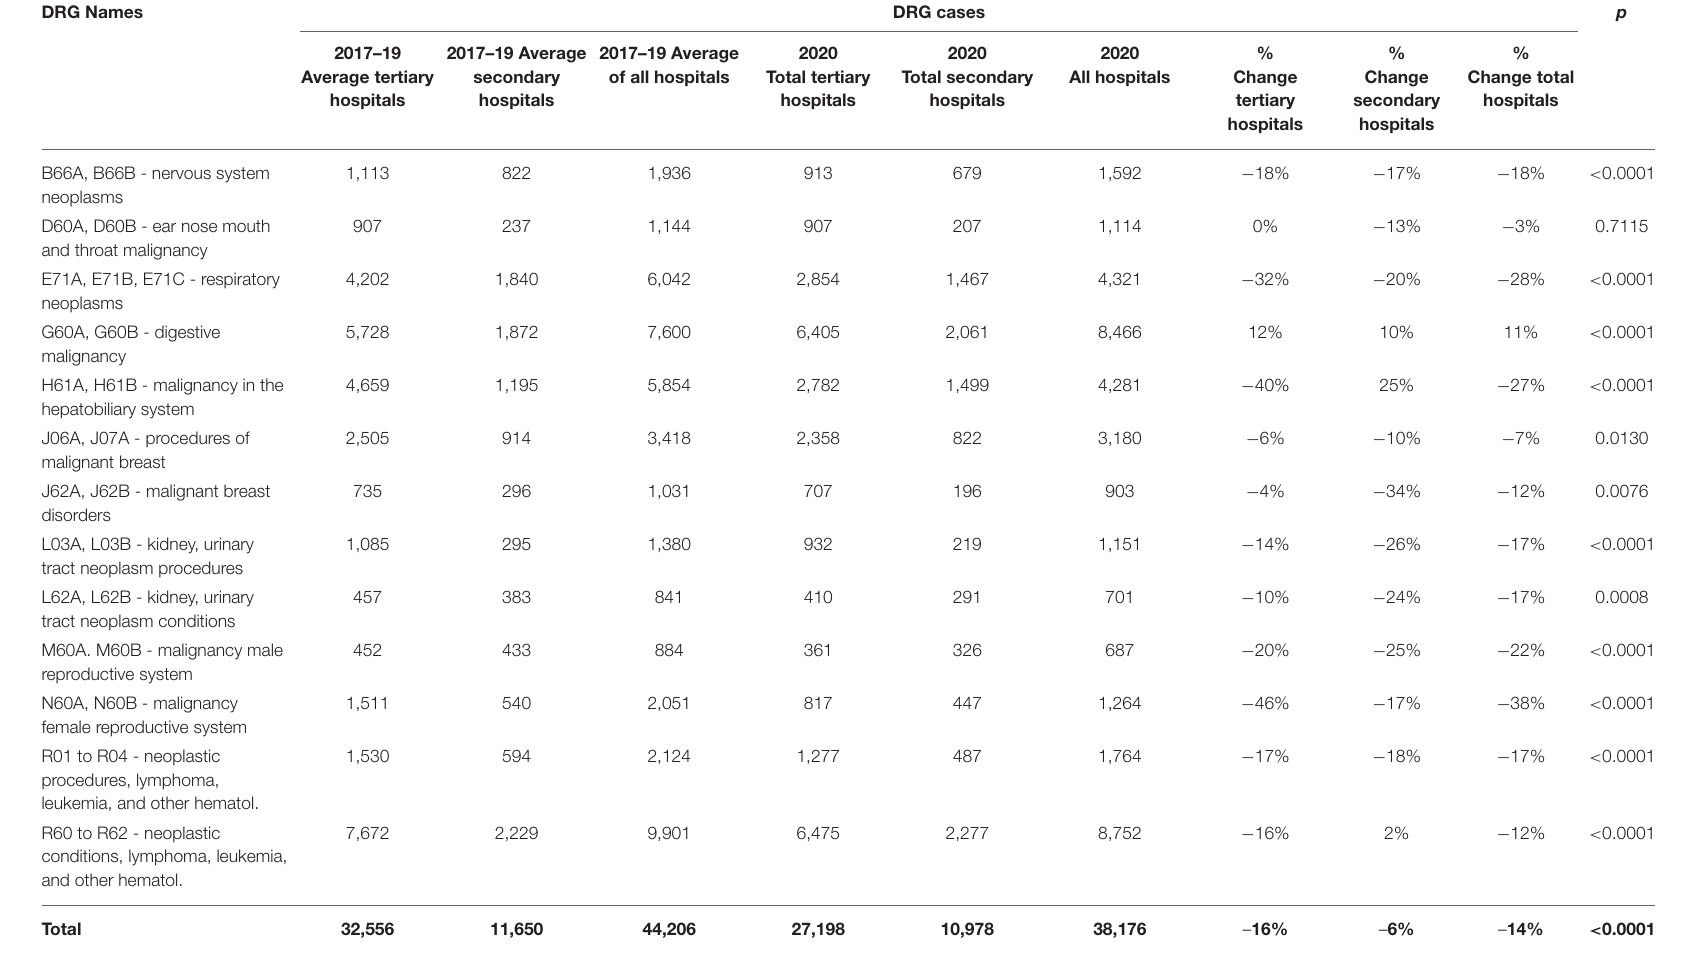
TABLE 3 | Difference in case activity in cancer and neoplasm related DRG classes before, and during Covid 19 in